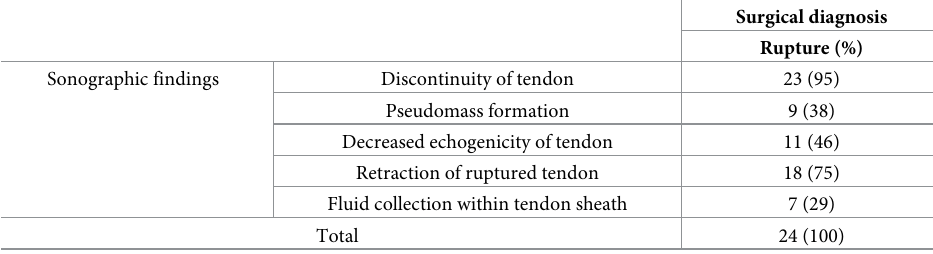
Table 1. Frequency of sonographic findings in tendon ruptures.